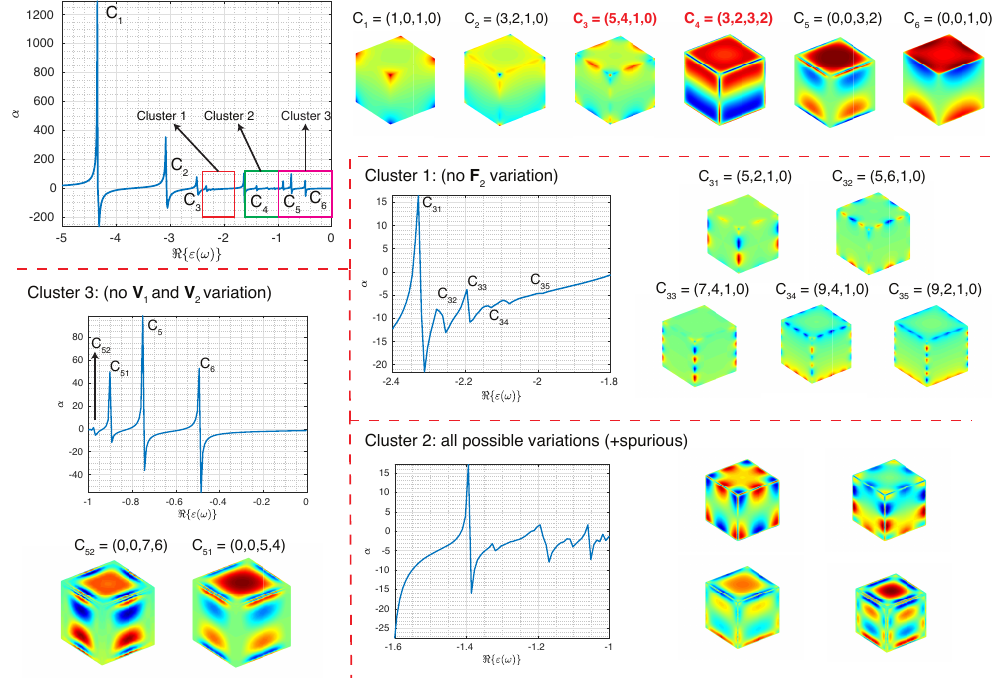
Figure 6. The six main resonances and the three particular clusters for the case of a sharp cube with p = 50 and a refined mesh. A total of 17 resonances and their surface potential distributions are presented. Above each resonance the categorization number is given, described in Figure 4. Please note that all resonances in clusters are more sensitive to modeling mesh density, than the main six resonances C 1 – C 6